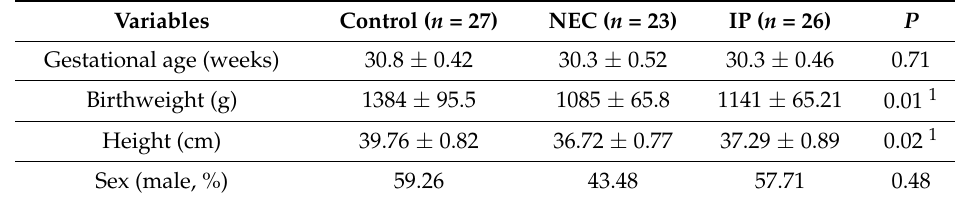
Table 2. Clinical and demographic characteristics of the neonatal